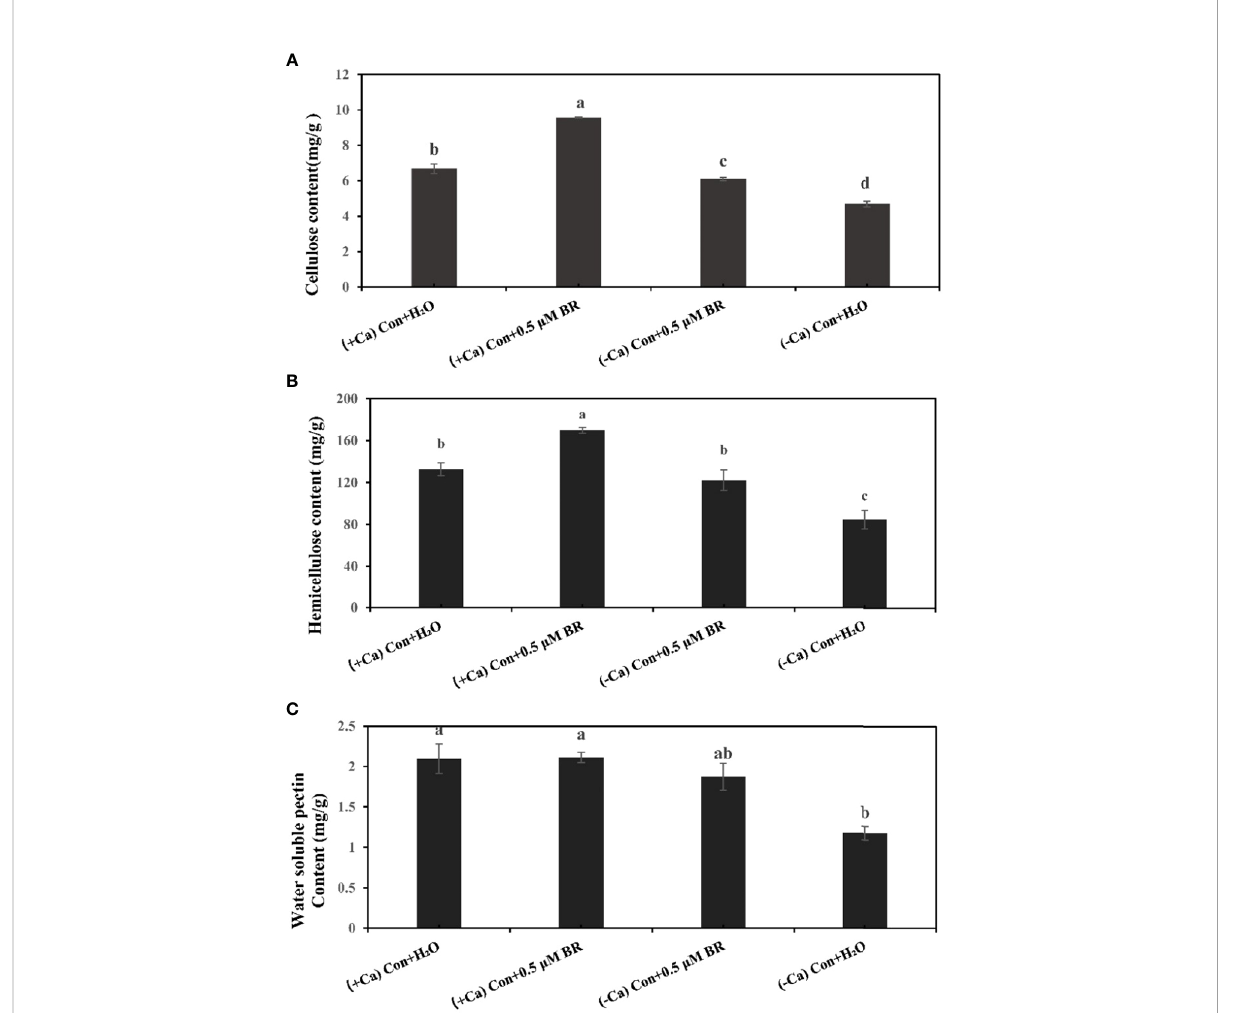
FIGURE 2 Effect of exogenous BRs on cell wall components of mini Chinese cabbage leaves. (A) cellulose. (B) hemicellulose. (C) water-soluble pectin. The different letters above the bars showed signi fi cantly different among treatments according to Duncan ’ s multiple test ( P<